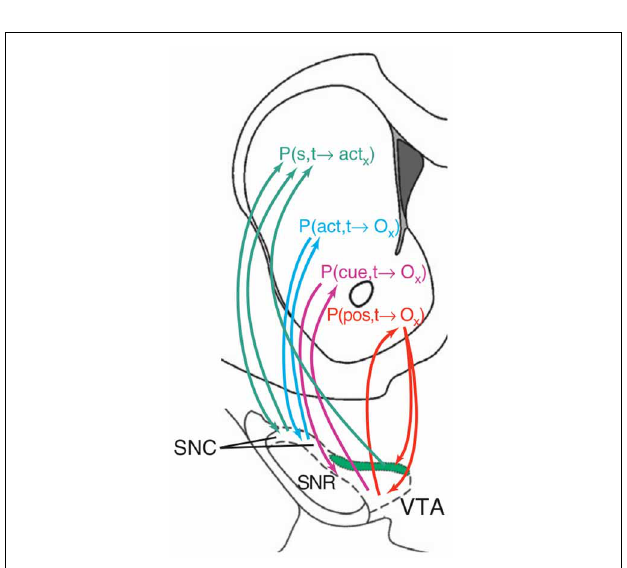
FIGURE 8 | An hypothesis of ventral striatum as the locus of various types of action-outcome anticipations. Reprinted from Pennartz et al. (2011), Copyright 2011, with permission from